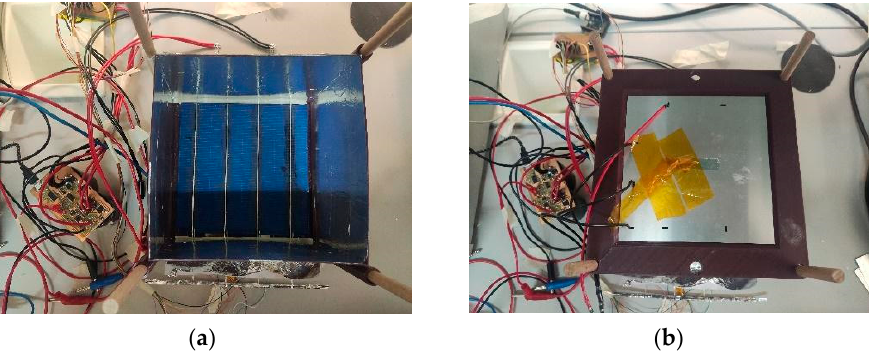
Figure 14. Modular platform mounted in the I-V tracer mode. ( a ) Assembled except for the LED board. ( b ) Fully assembled with the LED board in